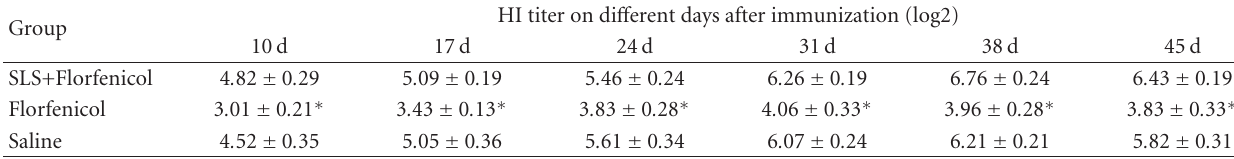
Table 5: Anti-immunosuppressive e ff ect of SLS on thiamphenicol.